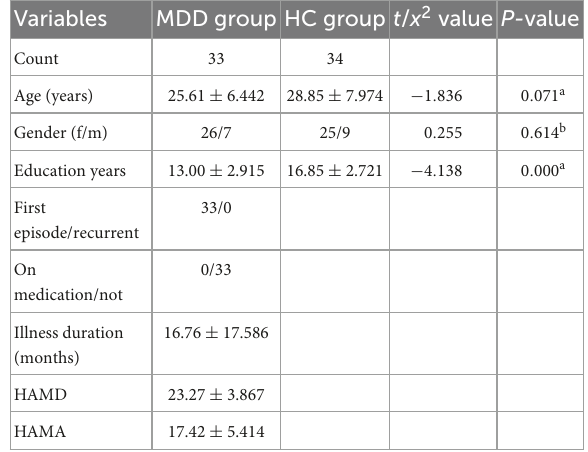
TABLE 1 Demographic data of the Subjects.